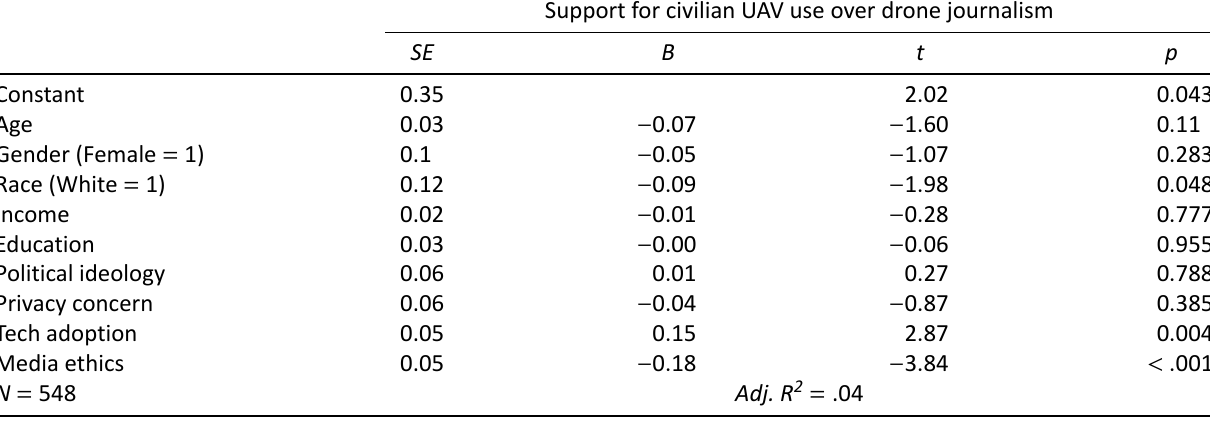
Table 6. The influence of privacy concerns, early technology adoption and perception of media ethics on the support gap between civilian UAV use and journalist UAV